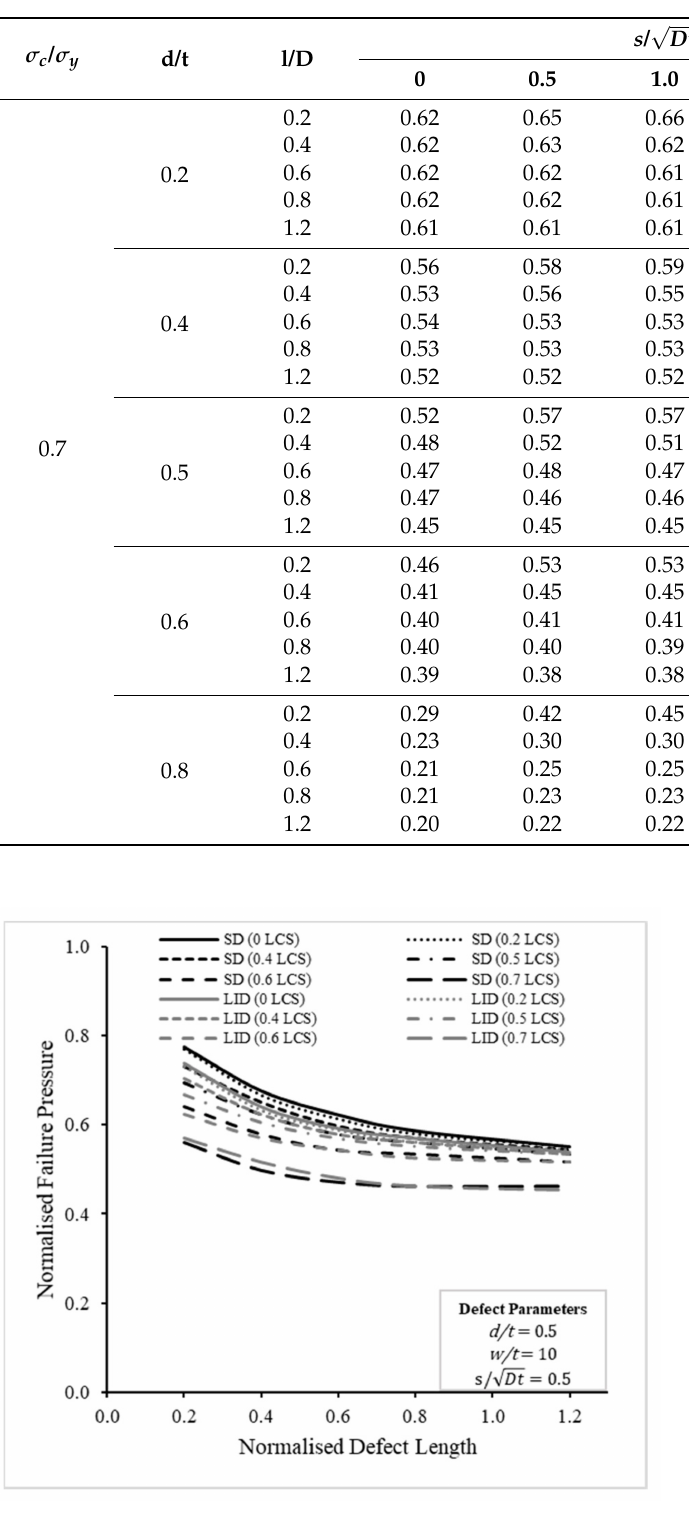
Table 10. FEA on corroded pipeline with LID subjected to internal pressure and 0.7 σ c / σ y longitudinal compressive stress.